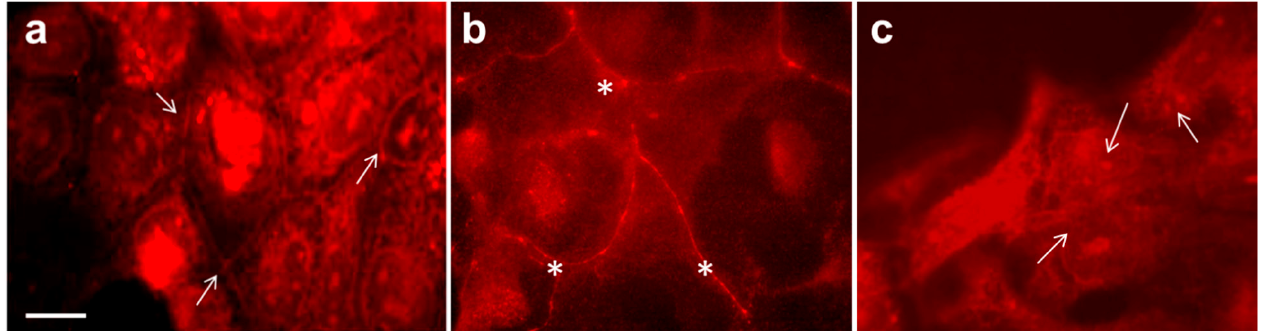
Figure 3. ZO-1 staining of untreated MDCKII cell line ( a ). MDCKII cells treated with 5 µ g/mL ( b ) and 20 µ g/mL ( c ) myconoside. Arrows and asterisks indicate the typical localization and distribution of ZO-1 proteins ( a , b ). A total of 5 µ g/mL myconoside strengthens linear cellular contacts ( b ), whereas 20 µg/mL myconoside disrupts linear ZO-1 organization ( c ). Scale bar: 10 µm.